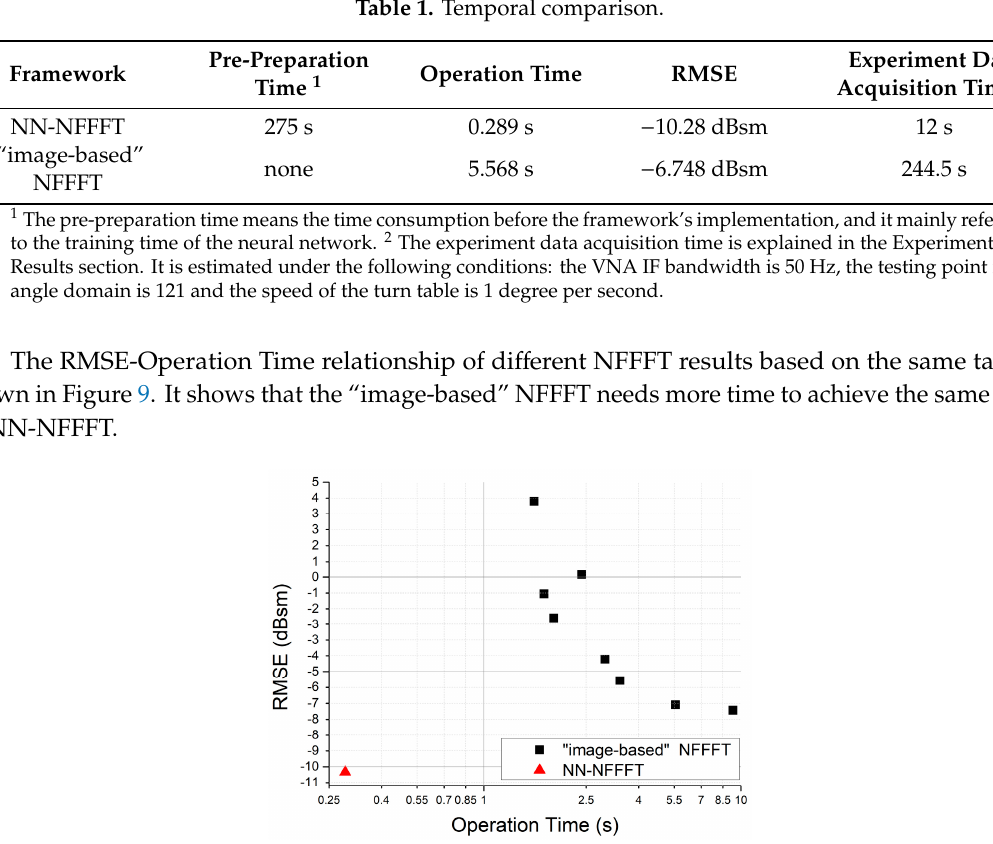
Table 1. Temporal comparison.